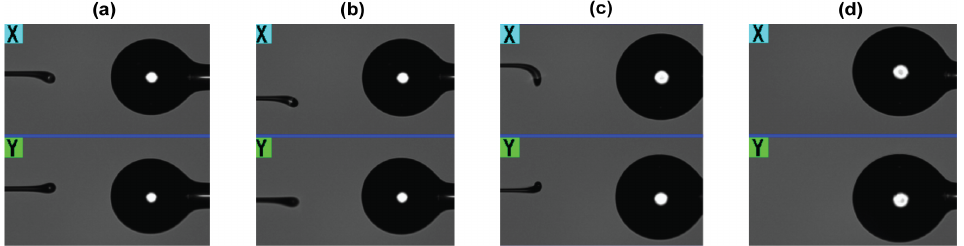
Figure 2. Ball resonator images taken by X and Y cameras of CO 2 laser splicing system ( a ) 378–374 μ m (BR1), ( b ) 386–380 μ m (BR2), ( c ) 433–426 μ m (BR3), ( d ) 449–443 μ m (BR4). BRs are shown on the right side of the images, while the left part shows the second fiber used for the formation of the spherical device.